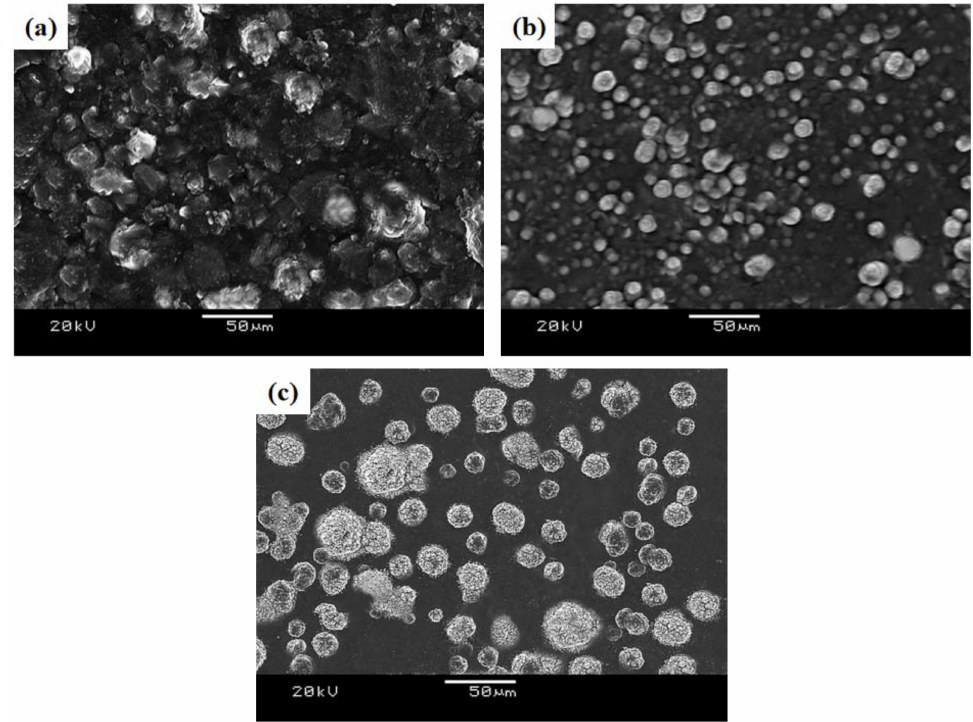
Figure 3. SEM images of Ni/TiN coatings produced at various laser powers: ( a ) 1 kW, ( b ) 1.5 kW, ( c ) 2 kW.